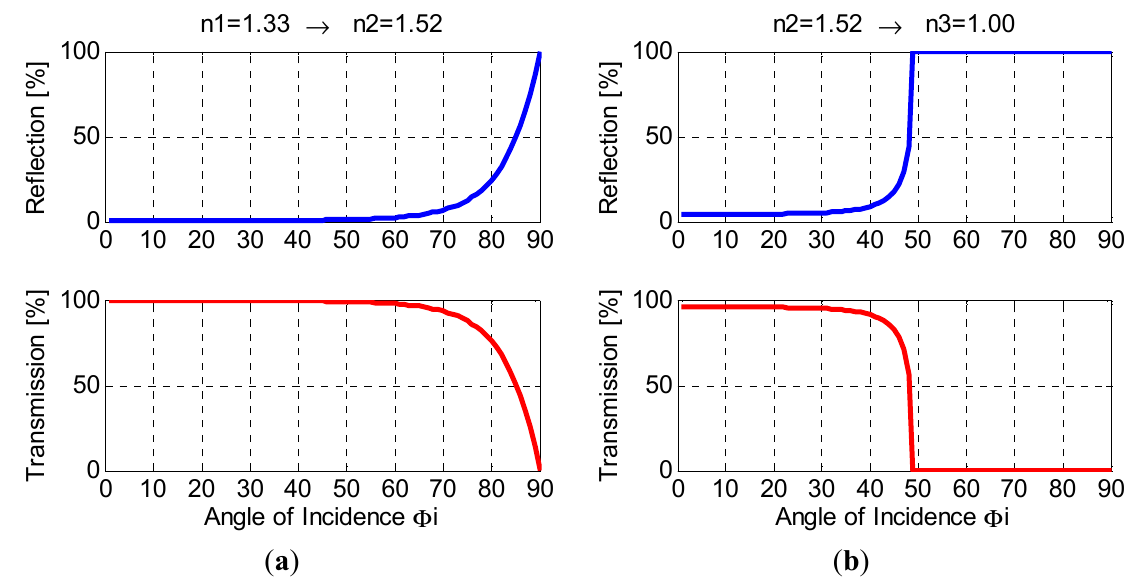
Figure 6. ( a ) Reflection and transmission from water to quartz with incident angles at the water-quartz interface Φ i of 0° to 90°; ( b ) resulting reflection and transmission from quartz to air observed for incident angles at the water-quartz interface Φ i of 0° to